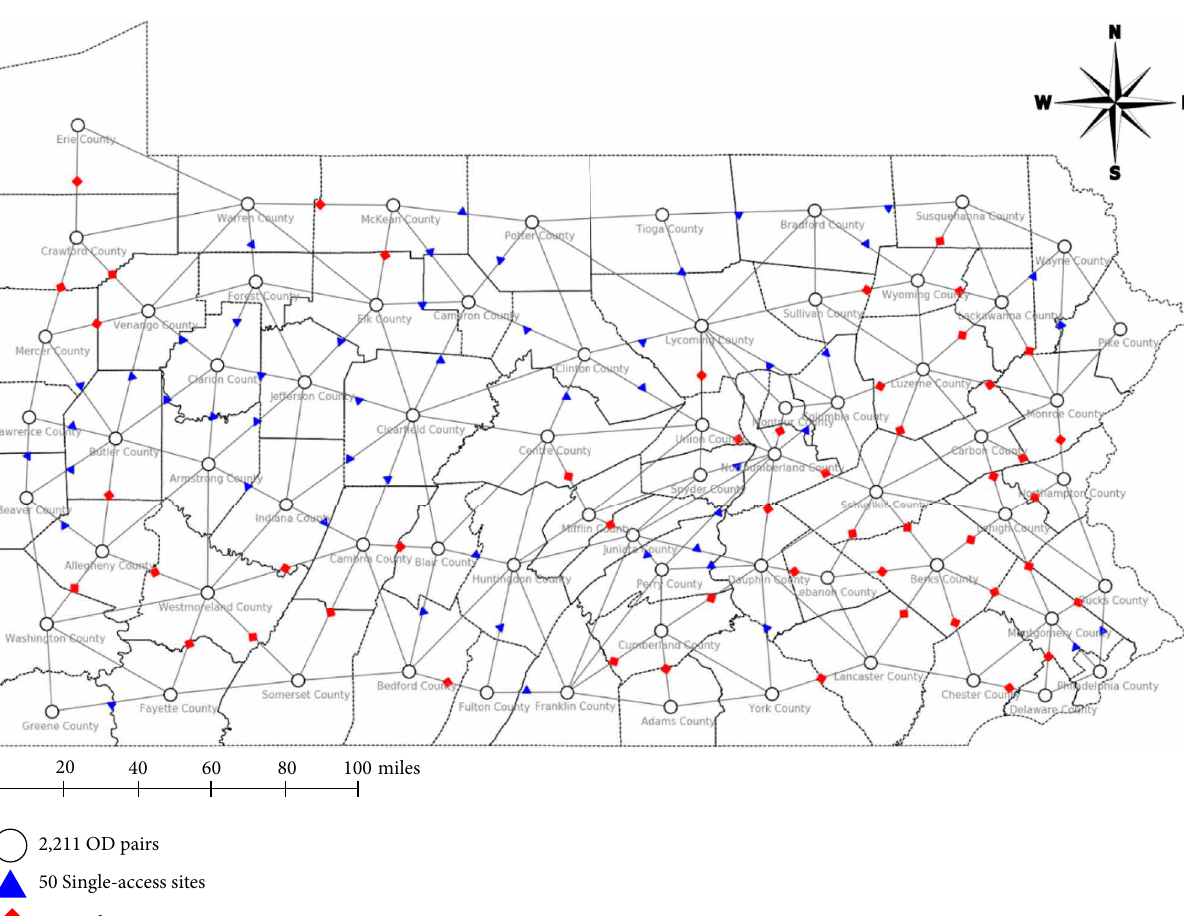
Figure 9: Trade-off between the optimal coverage and the construction budget for no-detour ( 퐾 = 1, 3 when 푅 = 300, 600 . (a)